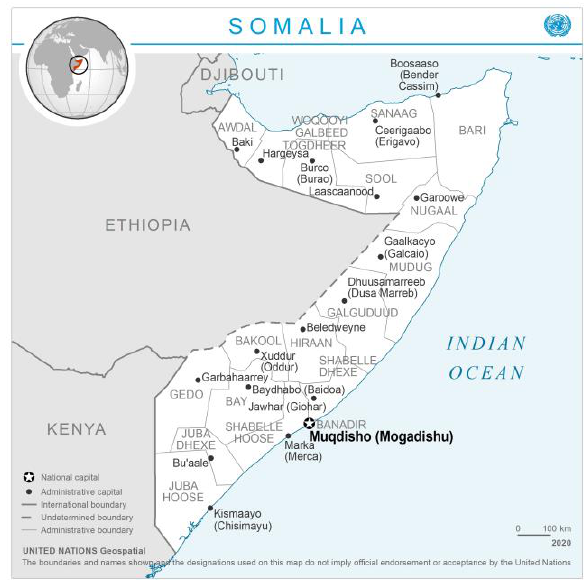
Figure 1. Map of Somalia (UN Geospatial, 2020) The civil war in Somalia severely affected the diversity of Somalis’ cities. Having once been inclusive, they become dominated by certain clans, causing some groups to feel excluded from rights, resources, power, and political life. Continued impunity hampers state-building, especially efforts to build a functioning justice system or to tackle corruption. Impunity fosters grievances, including by benefiting dominant clans, which causes weaker clans to turn to Al-Shabab 1 and other armed groups. (Keating M. and Wildman M., 2018). In 2004 the Somali leaders agreed on the establishment of a Transitional Federal Government (TFG). During the year of 2006, the Islamic Courts Union (ICU) took over much of the south. The TGF with the assistance of Ethiopian troops and the African Union 2 peacekeepers manage to drive ICU out. Radical elements, including Al-Shabab, regrouped to resume the insurgency against the TFG and oppose the Ethiopian military presence. By 2008 Al-Shabab gained control of key areas, including Baidoa [city].